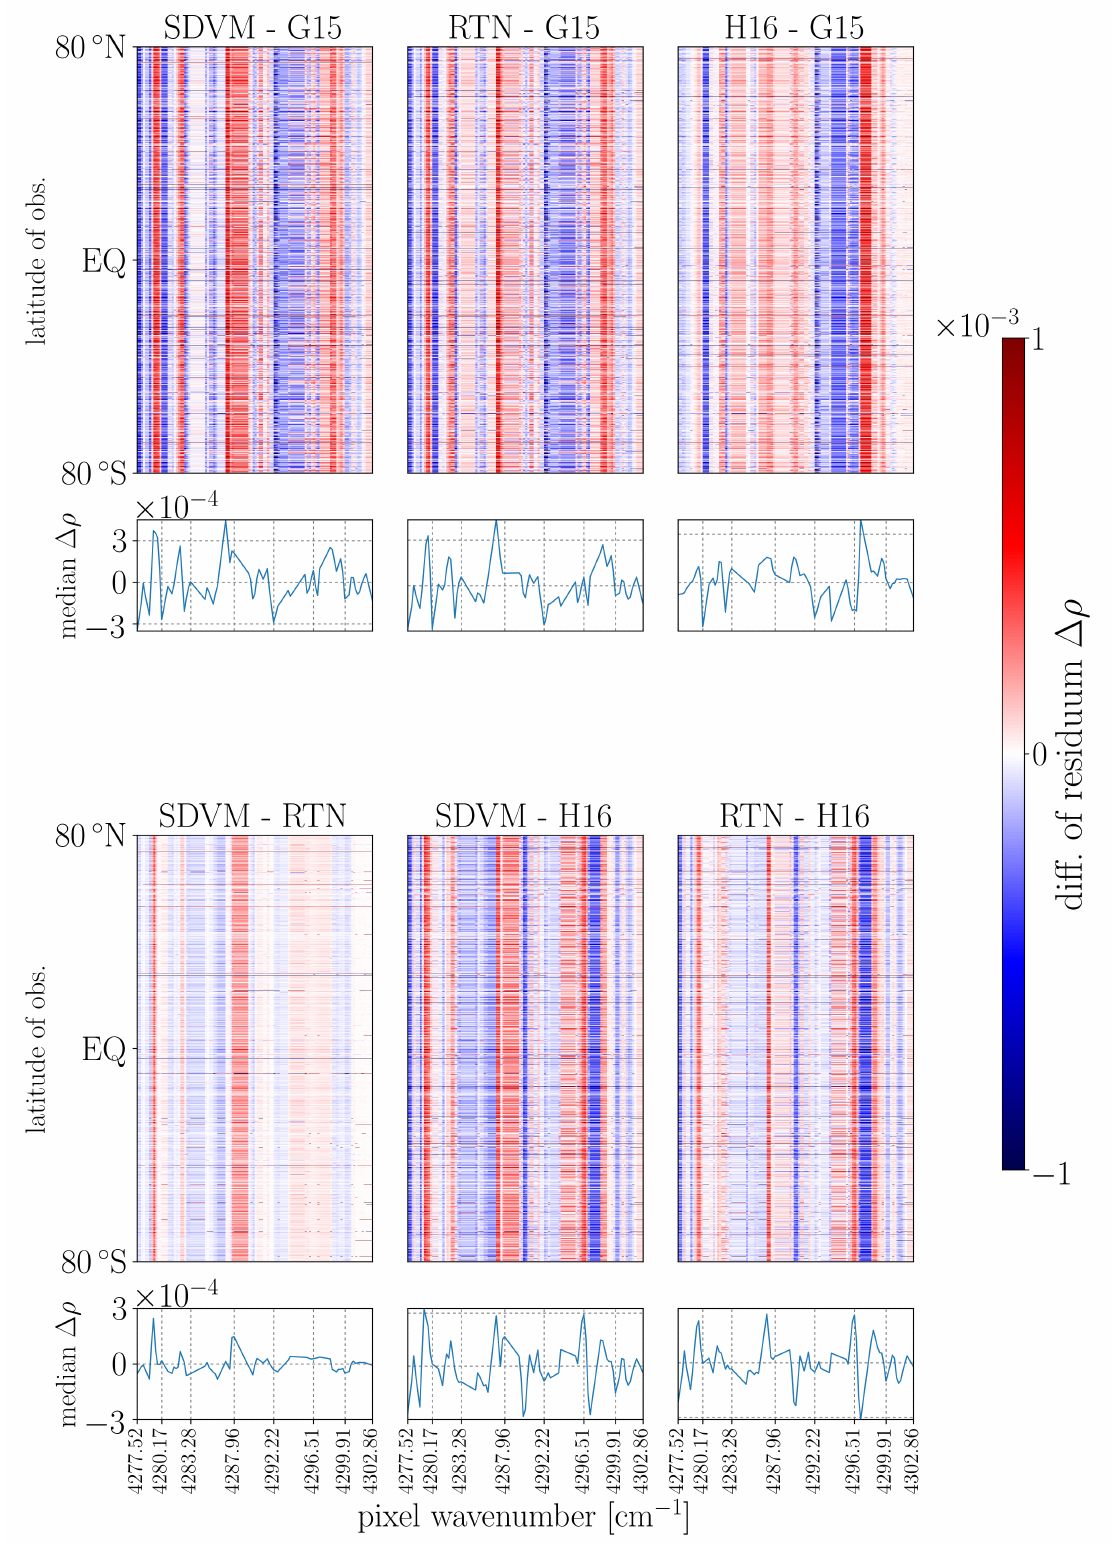
Figure 3. Difference in the spectral fitting residuals for various spectroscopic inputs and line models. The x-axis of each figure shows the 71 sensor pixels in the CO fitting window. The y-axis in the pseudocolor plots depicts 2090 observations in orbit 13212 from southern to northern latitudes and the lower panels show the median of the residuals for each